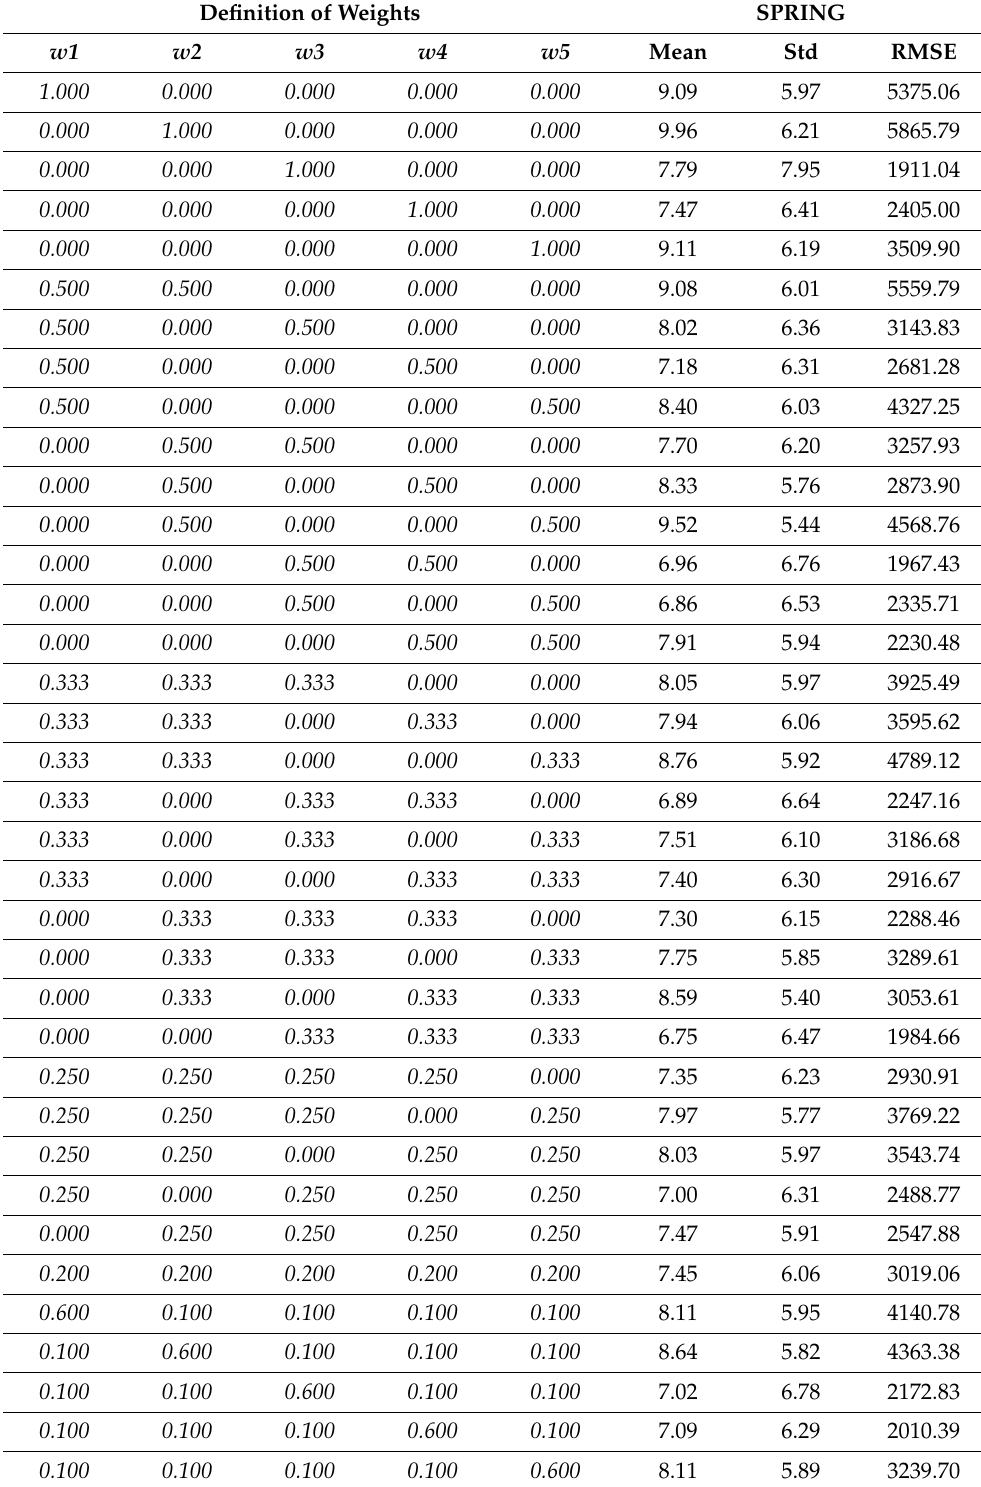
Table 8. Mixture DOE arrangement considering four elements to be combined. Results for spring are